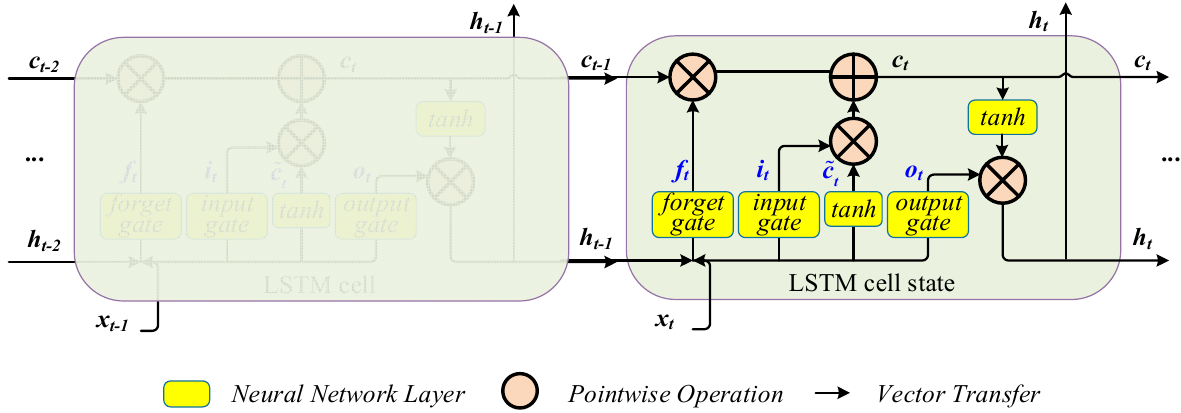
Figure 4. Structure of the LSTM model.